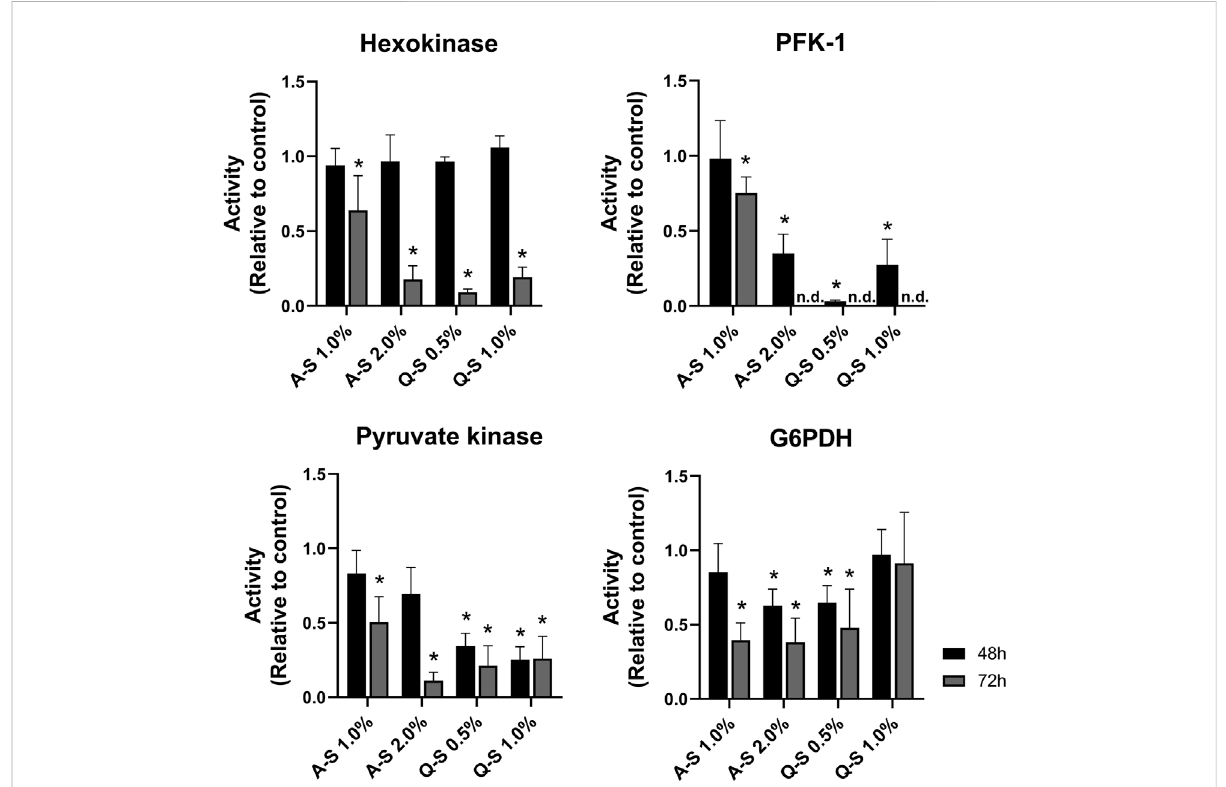
FIGURE 5 Effect of V. album summer mother tinctures on the MDA-MB-231 glycolysis and pentose phosphate pathway enzymes. HK, PFK-1, PK (glycolytic enzymes), and G6PDH (Pentose Phosphate Pathway) were analyzed after 48 h (black bars) and 72 h (grey bars) of the treatment with A-S (1.0% and 2.0% v/v) and Q-S (0.5% and 1% v/v). Mean values ±standard error of two independent experiments ( n = 2). * p ≤ 0.05 were compared to control (ethanol at the same concentration of MTs) by nonparametric Mann-Whitney test. Legend symbols: V. album subsp. abietis growing on Abies alba in summer (A – S); V. album subsp. album growing on Quercus petraea in summer (Q –